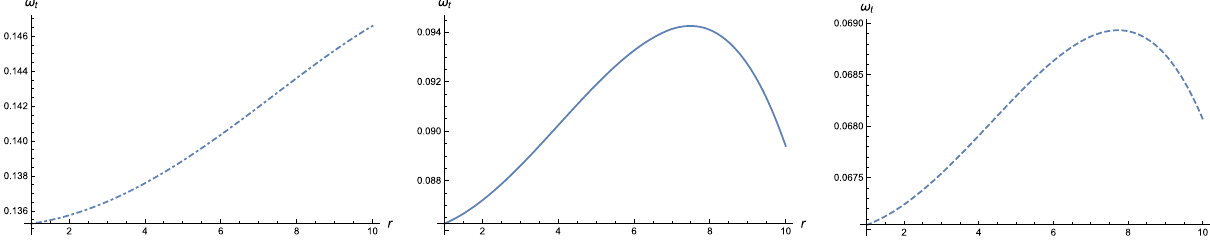
Fig. 14 Variations of the tangential EoS parameter with respect to the radial coordinate r (km) of the strange star candidate Her X-1, SAX J 1808.4-3658, and 4U 1820-30; represented by (left to right) the first, second, and third graphs,